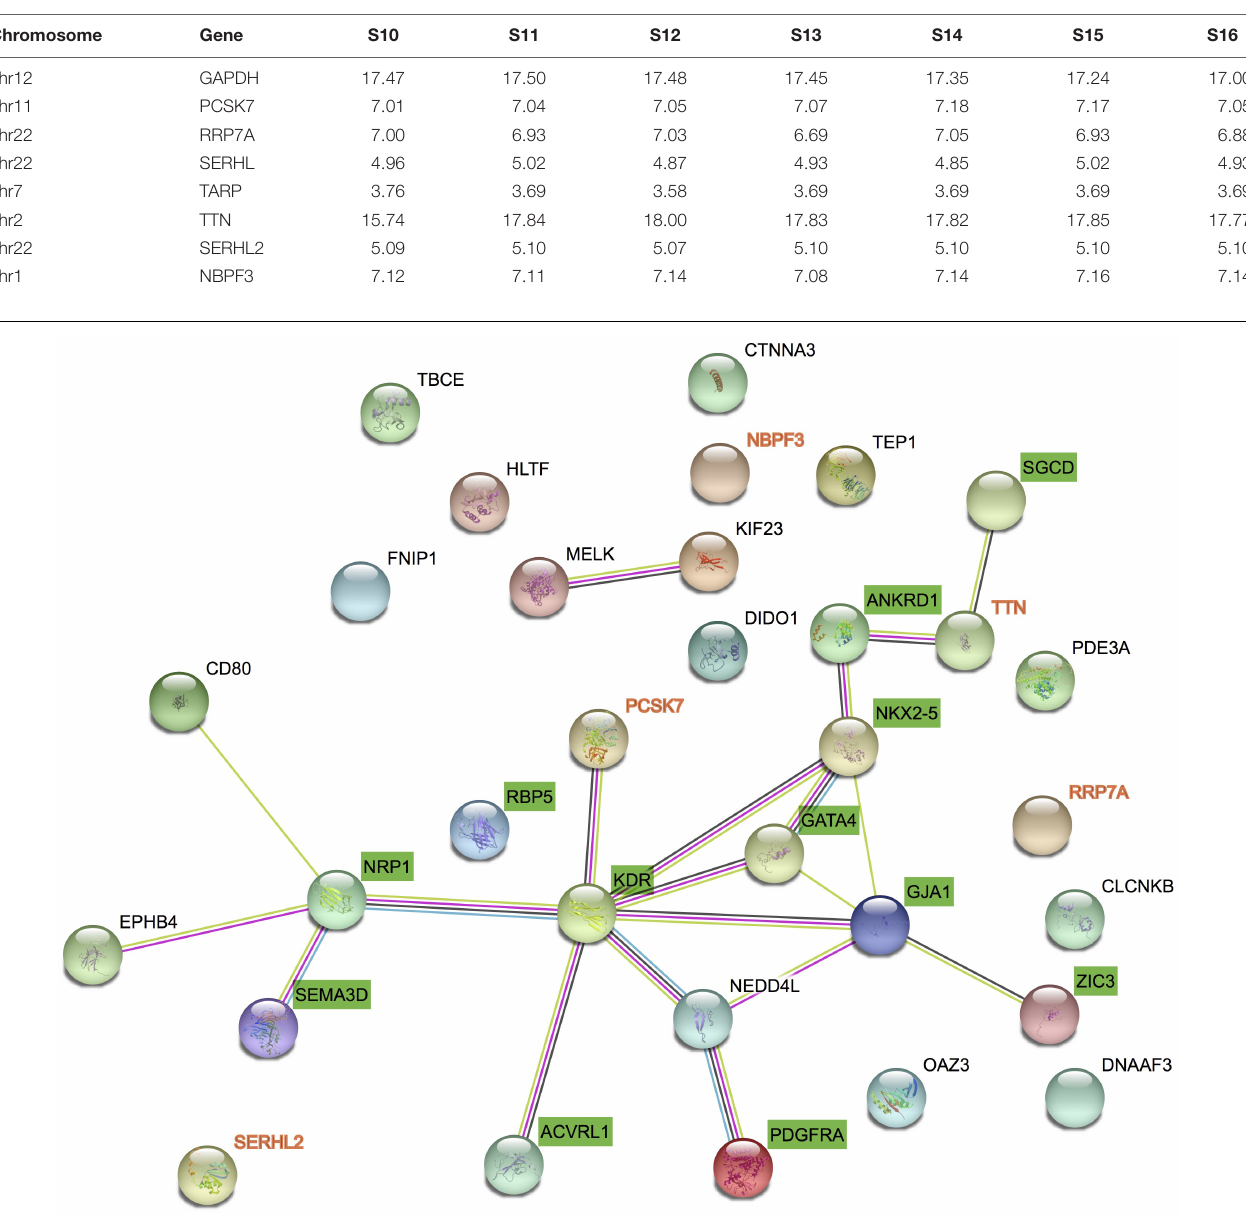
TABLE 3 | Expression patterns of candidate genes in human embryonic hearts at different time points. Chromosome